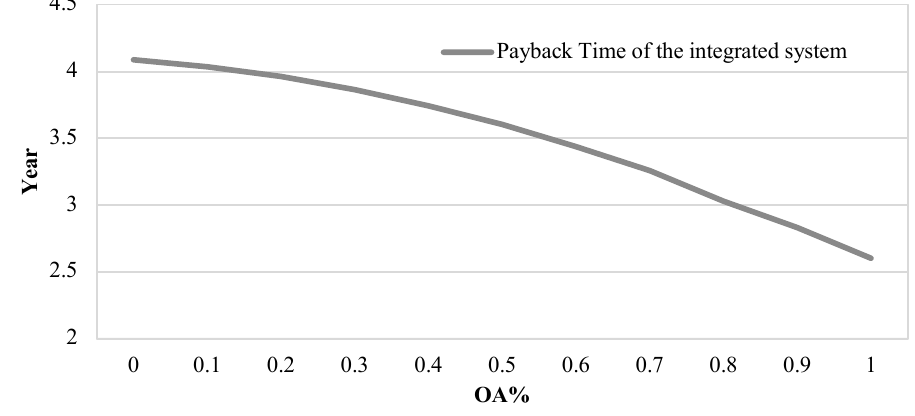
Figure 5. Payback